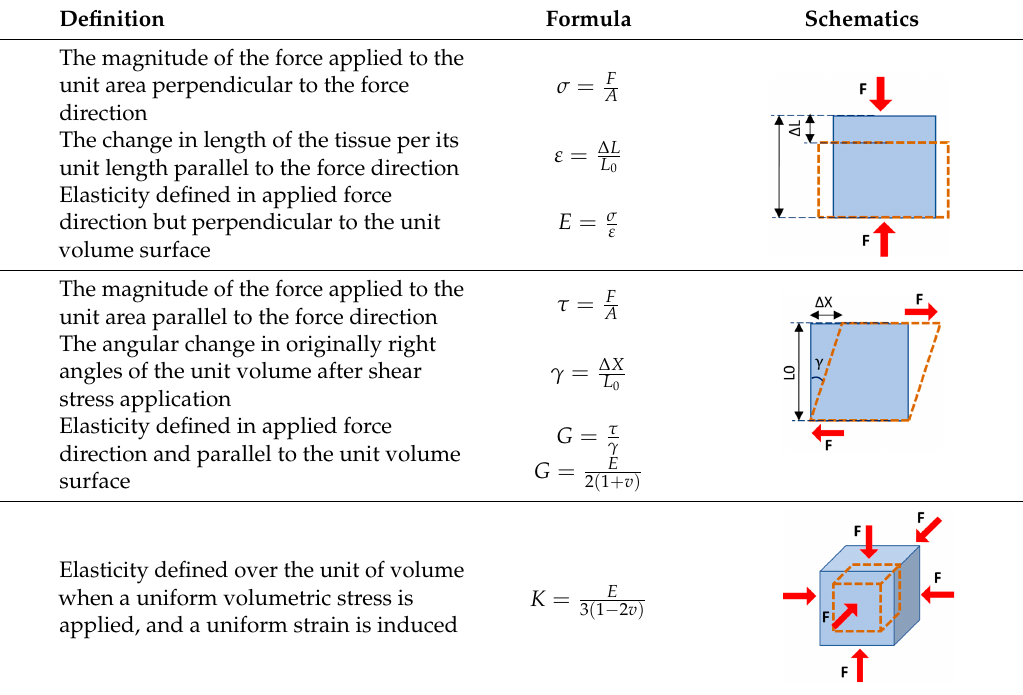
Table 2. Definition of the basic mechanical parameters described in this study.